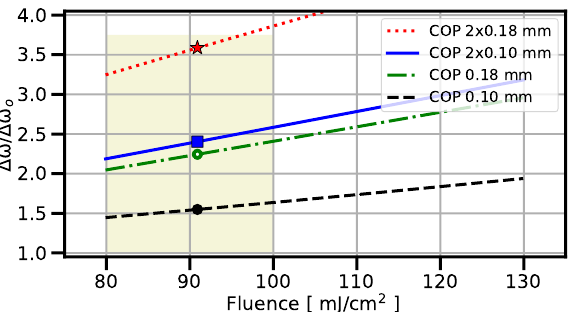
Figure 5. Simulated response of the COP film obtained from a 1-D simulation in PyNLO for initial pulse duration of 25 fs. The induced increase in bandwidth ( ∆ ω ) relative to the original reference bandwidth ∆ ω 0 of the input pulse is shown relative to pulse fluence for examples of a single film and two films. The shaded region highlights the values that correspond to the relevant pulse fluences of 80–100 mJ/cm 2 . The points correspond to bandwidths supporting ftl pulse durations of 17.75 ( • ), 12.75 ( ◦ ), 12.0 ( (cid:4) ), 8.25 ( (cid:63) )